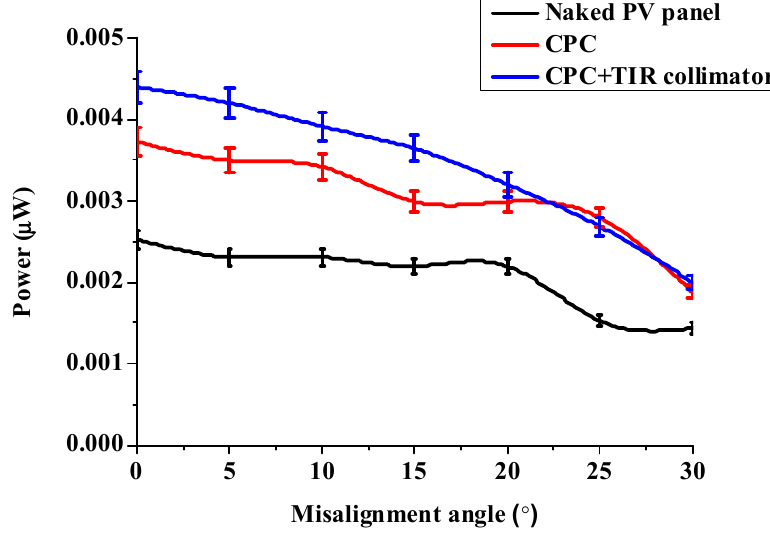
Figure 28. The experimental results of the CPC with the Figure 29. The experimental results of the CPC with the collimator. Figure 29. The experimental results of the CPC with the collimator.